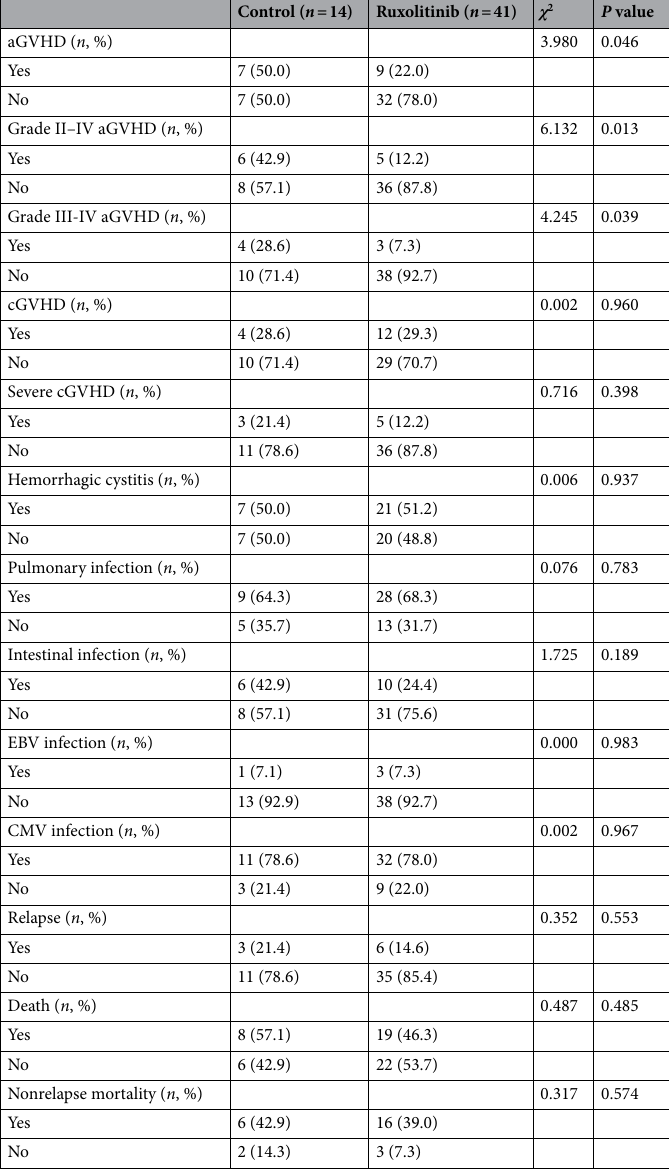
Table 2. Complications and prognosis of all patients in the control and ruxolitinib groups ( N = 55). CMV Cytomegalovirus, EBV Epstein-Barr virus, GVHD graft-versus-host